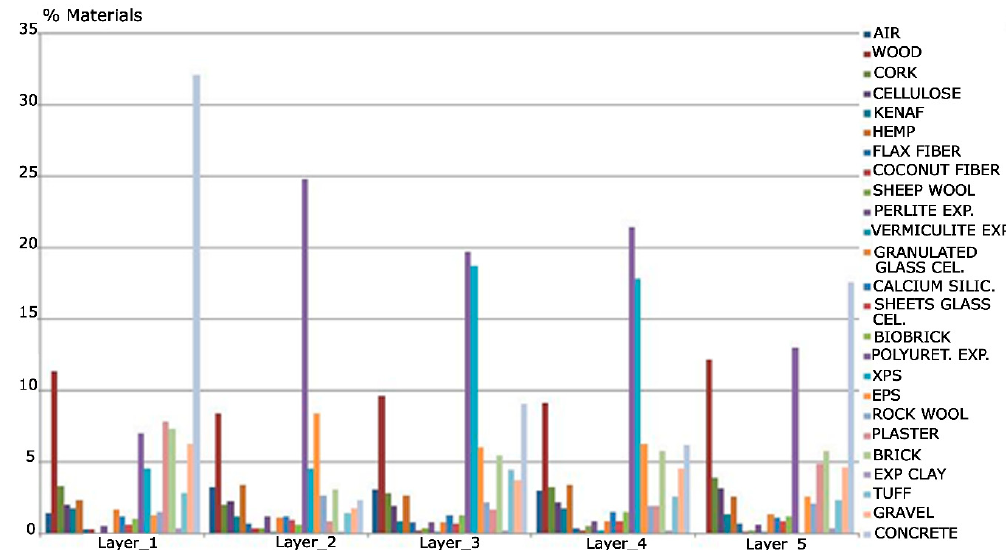
Figure 4. Histogram showing the probability of finding a material on a given layer for a slab-on-ground with no constraints imposed in the stratigraphy.